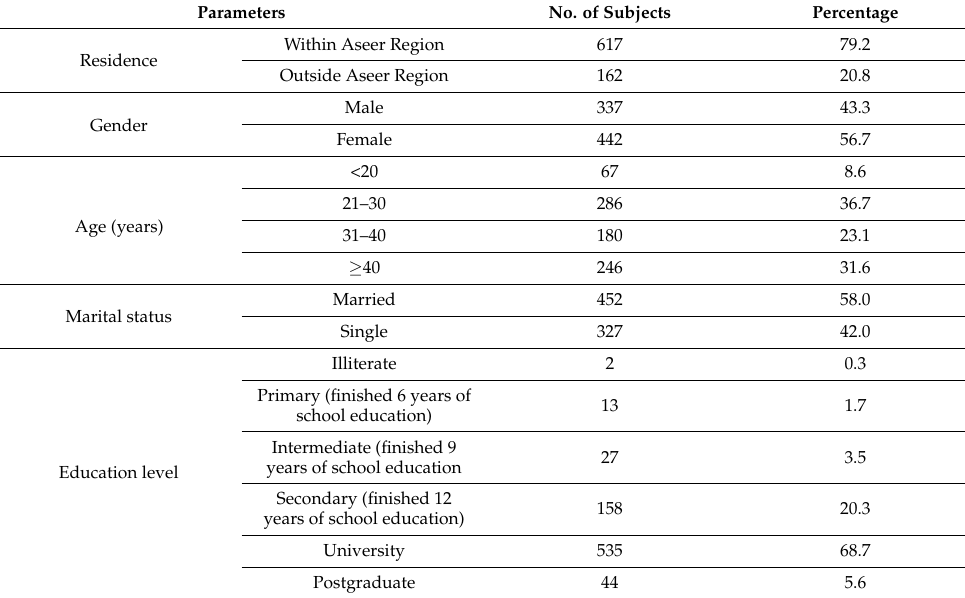
Table 1. Demographic data ( n =